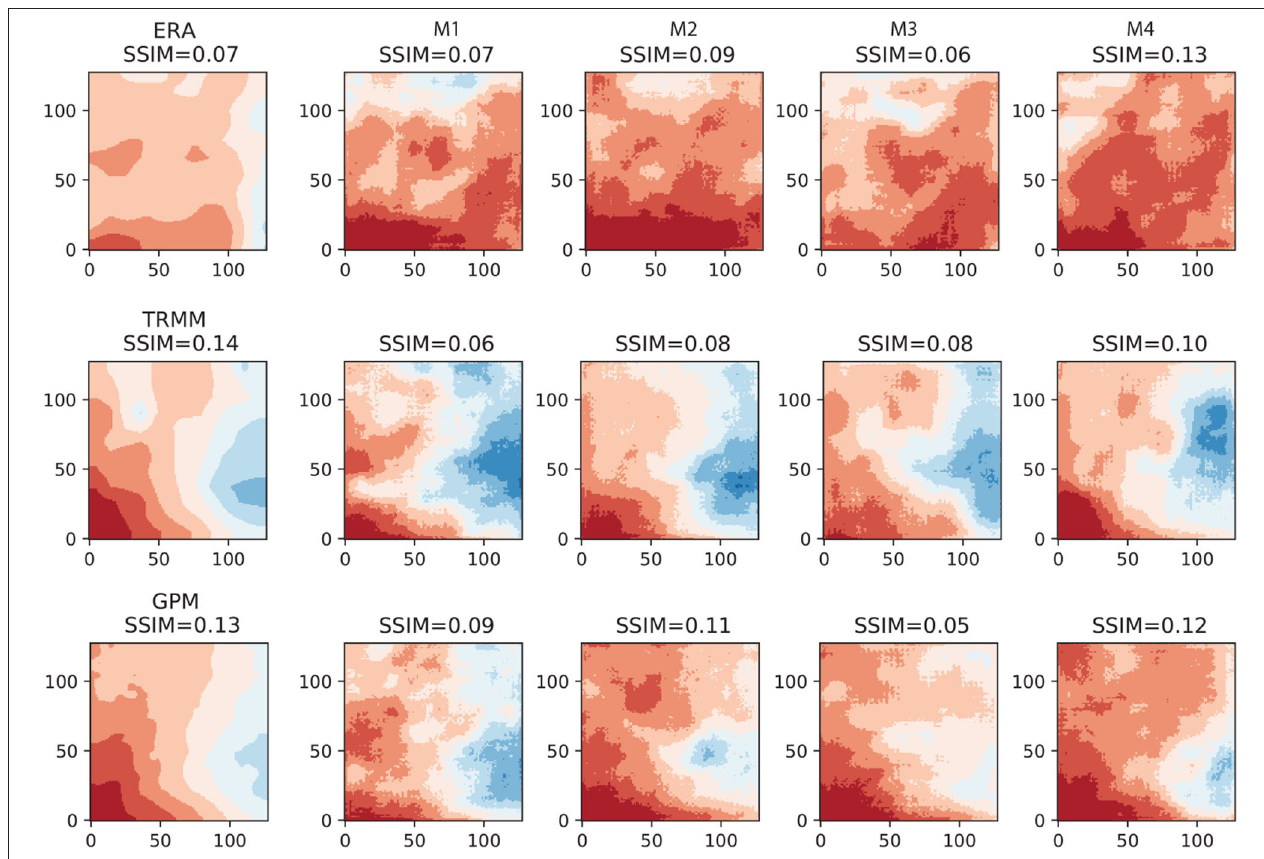
FIGURE 13 | Results of U-Net models for 2017/01. Top row: ERA5 results; mid-row: TRMM results; and bottom row: GPM